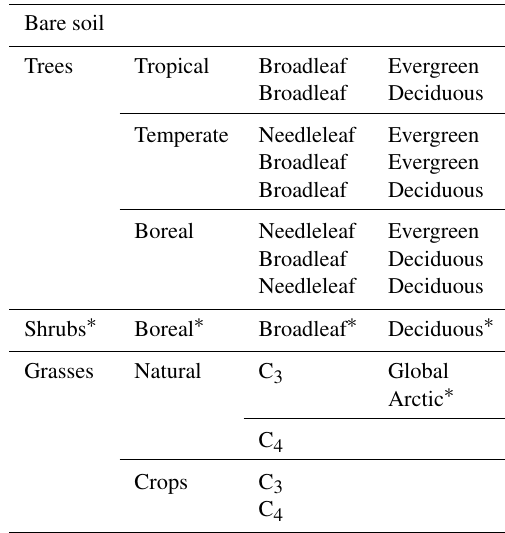
Broadleaf Needleleaf Broadleaf ∗